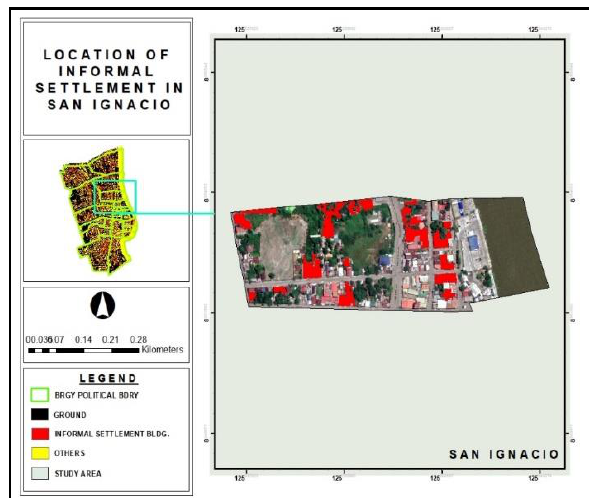
Figure 6. Informal Settlement in Brgy. Port Poyohon